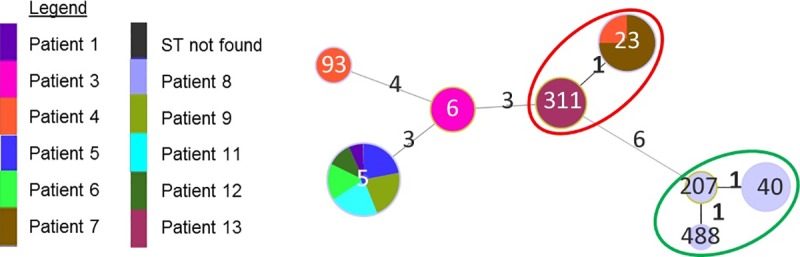
Minimum Spanning Tree showing distribution of the isolates according to patient distribution.Each patient is identified by one colour. ST forming CC are indicated by coloured circles; with a red circle showing CC including VN I isolates and a green circle showing CC including VN II isolates from the present study. Not circled STs form singletons.